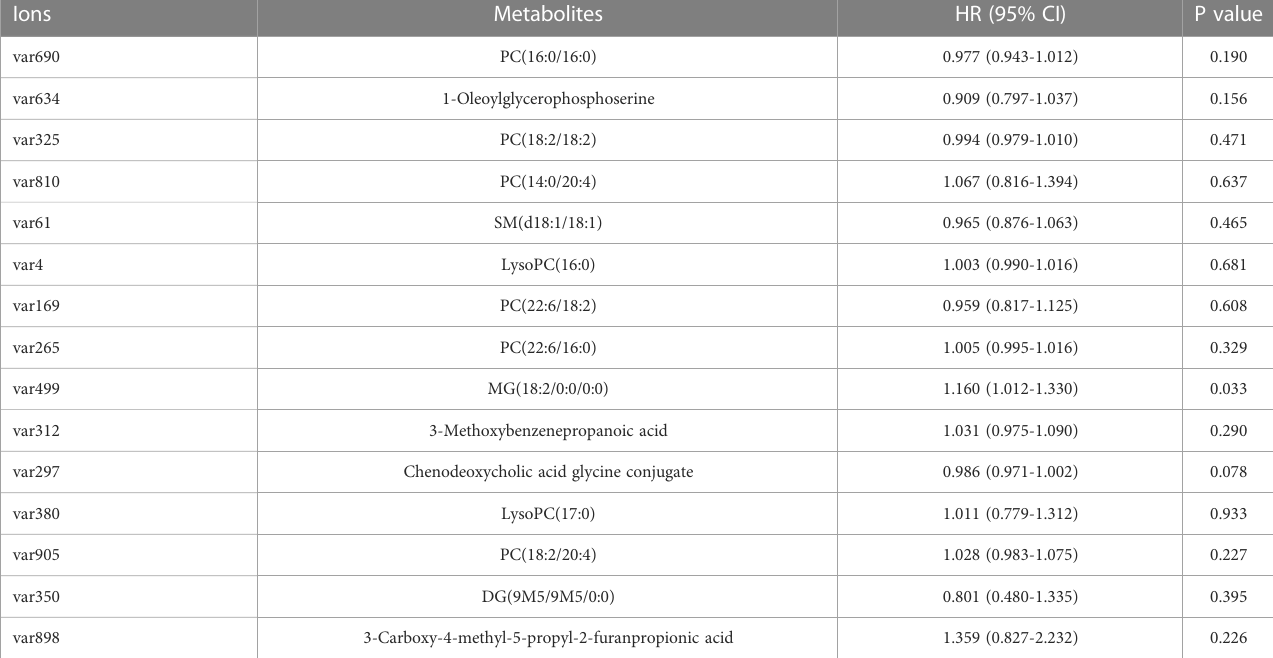
TABLE 3 Univariate Cox regression analysis for predictive factors of tumor-free survival.